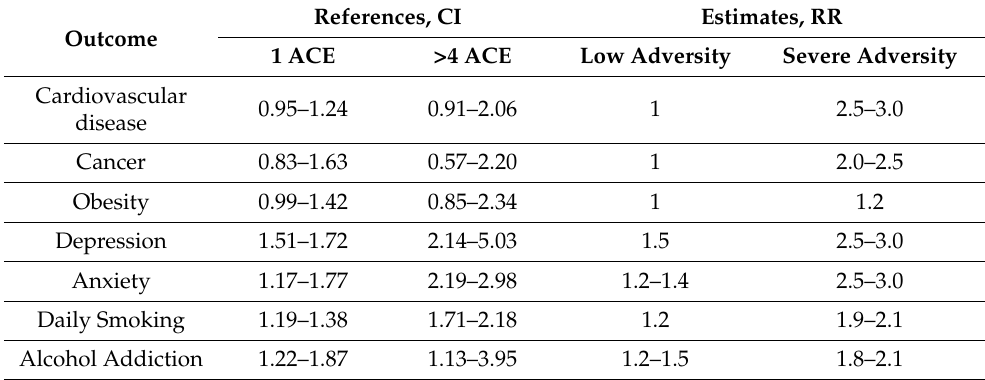
Table 1. Hypothesis estimates based on results from studies using ACE Q scores.